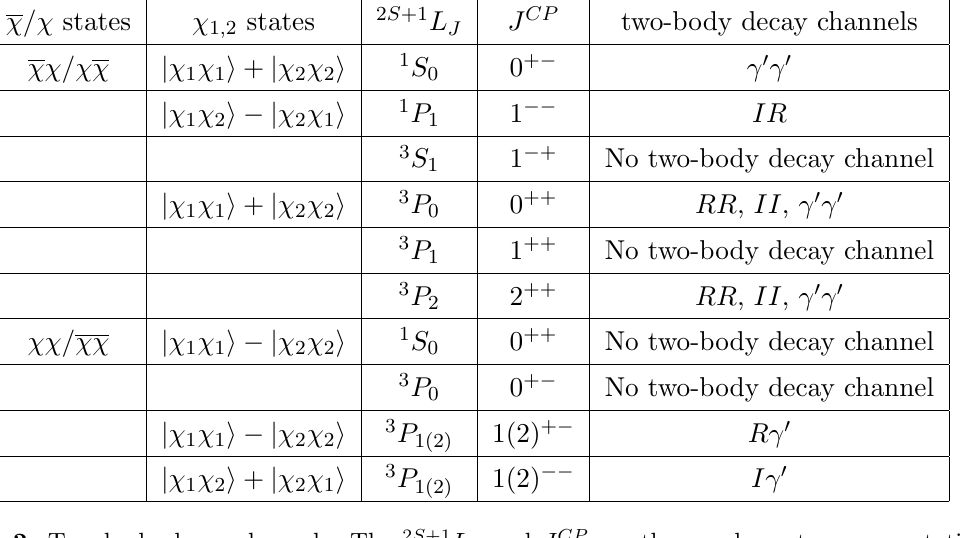
Table 2 . Two-body decay channels. The 2 S +1 L J and J CP are the usual spectroscopy notations, indicating the quantum numbers of the total spin S , orbital angular momentum L , total angular momentum J , C -parity, and parity under space